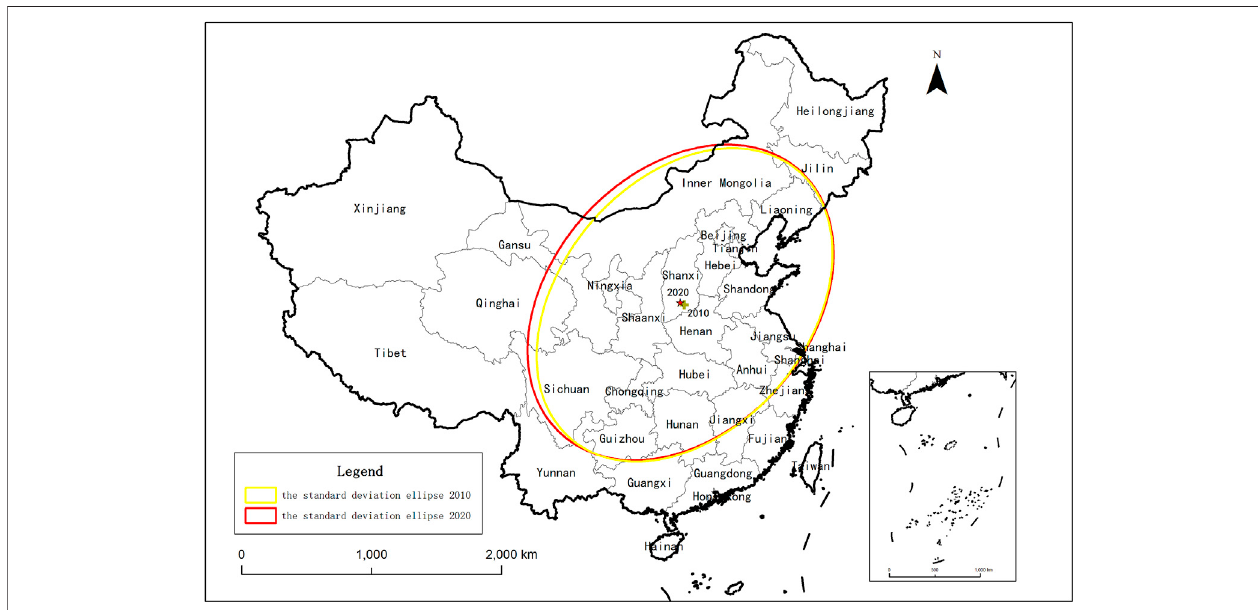
FIGURE 2 | The standard deviation ellipse of China during 2010 –